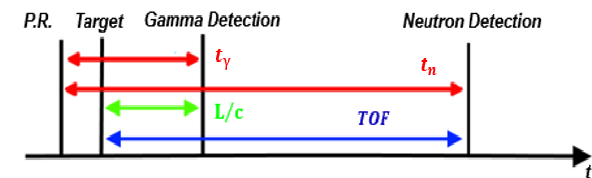
Figure 5 Time of flight scheme for neutron-gamma